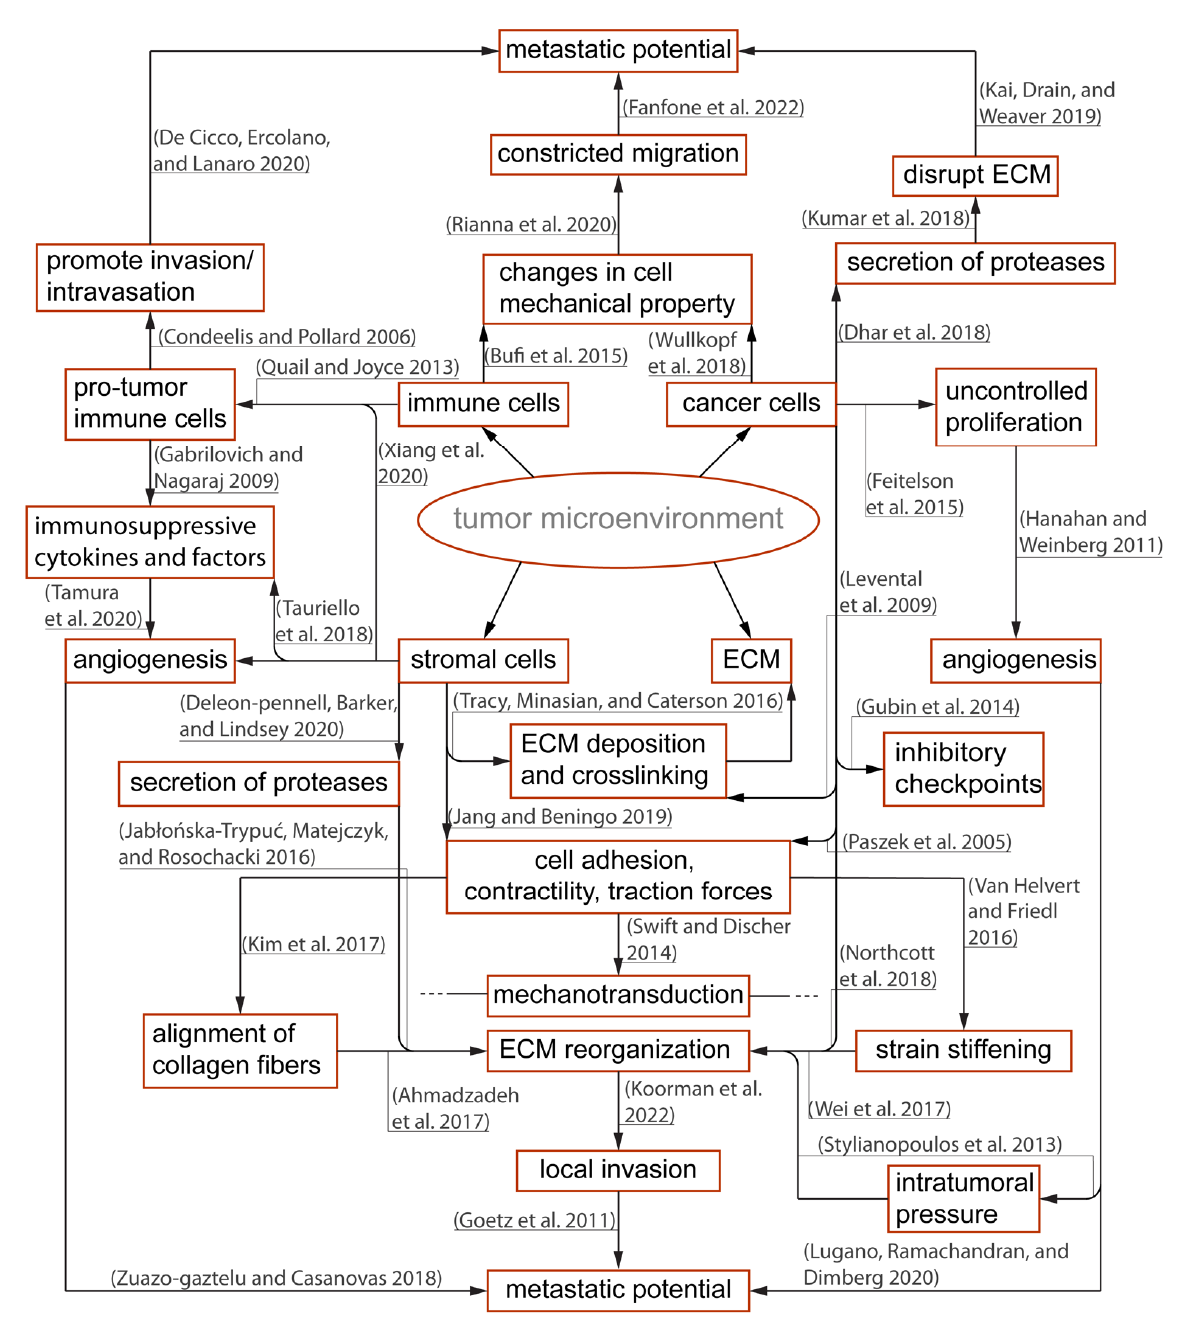
Figure 2. Overview of the immunosuppressive tumor microenvironment (TME) and important con- tributors to tumor progression: Within the TME, there is a dynamic relationship between peritumoral and intratumoral components that include immune cells, cancer cells, and the stromal elements often exhibiting context-dependent functionality. Different components of the TME carry out pro- or anti-tumor functions, and such polarizations are caused by reciprocal interactions with physical and biochemical cues from the surroundings. The polarized functions are not distinctive but rather hetero- genous contributing to an immunosuppressive TME [5,19,20,28,29,35,39,40,46,48,53–75].